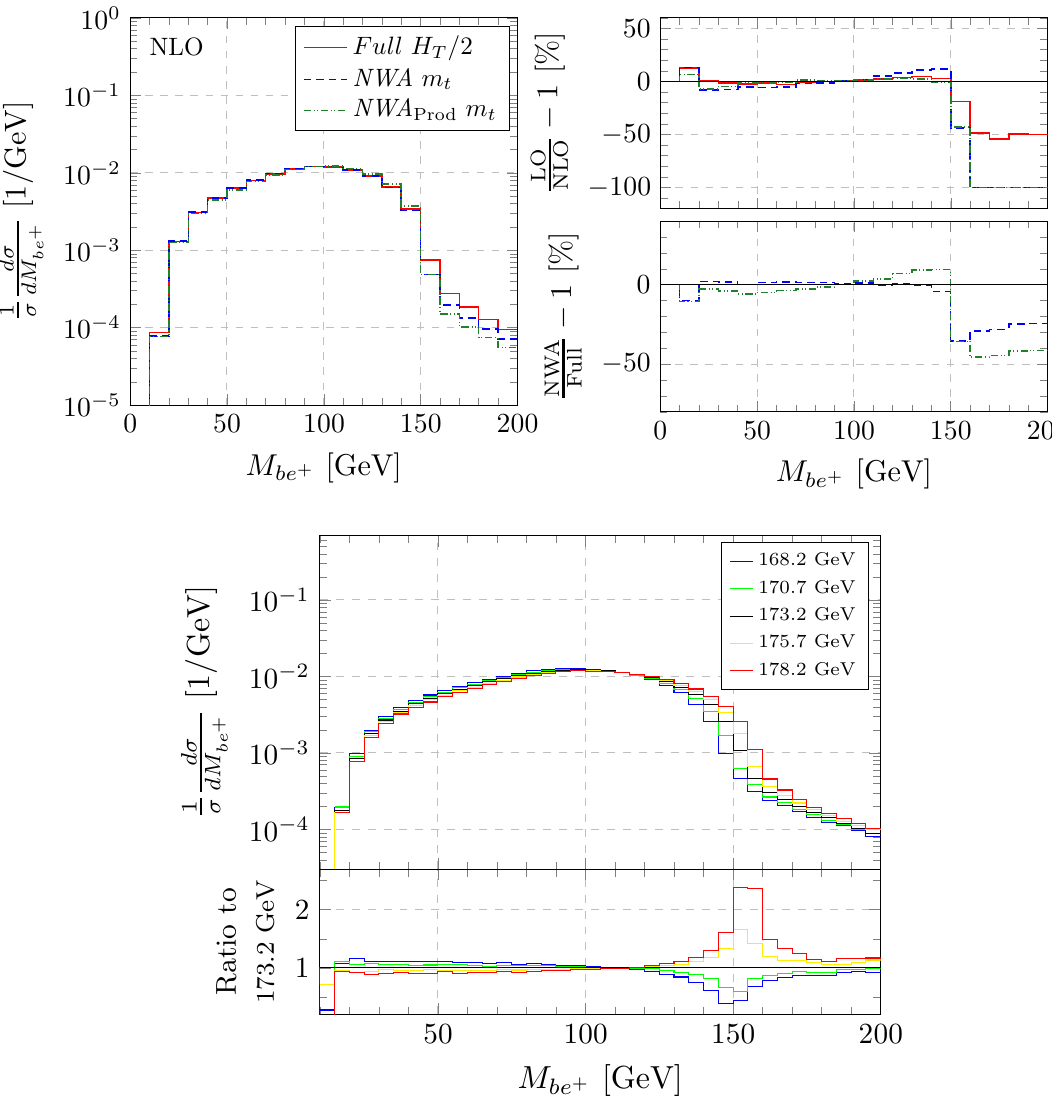
(cid:22) bj + X production + (cid:23) Figure 15 . Normalised M b‘ distribution at NLO QCD for the pp ! e e (cid:22) (cid:0) (cid:22) (cid:23) (cid:22) b process at the LHC with p s = 13 TeV. The CT14 PDF set is used. Upper panel: three di(cid:11)erent theoretical descriptions with m t = 173.2 GeV and (cid:22) R = (cid:22) F = (cid:22) 0 , where (cid:22) 0 = m t for both NWA cases and (cid:22) 0 = H T = 2 for the Full case. Also given are the relative size of NLO QCD corrections and the combined relative size of (cid:12)nite-top-width and (cid:12)nite-W-width e(cid:11)ects for the normalised M b‘ observable. Lower panel: the Full case for (cid:12)ve di(cid:11)erent top quark masses for (cid:22) 0 = H T = 2. Also plotted is the ratio to the result with the default value of m t , i.e. m t = 173.2